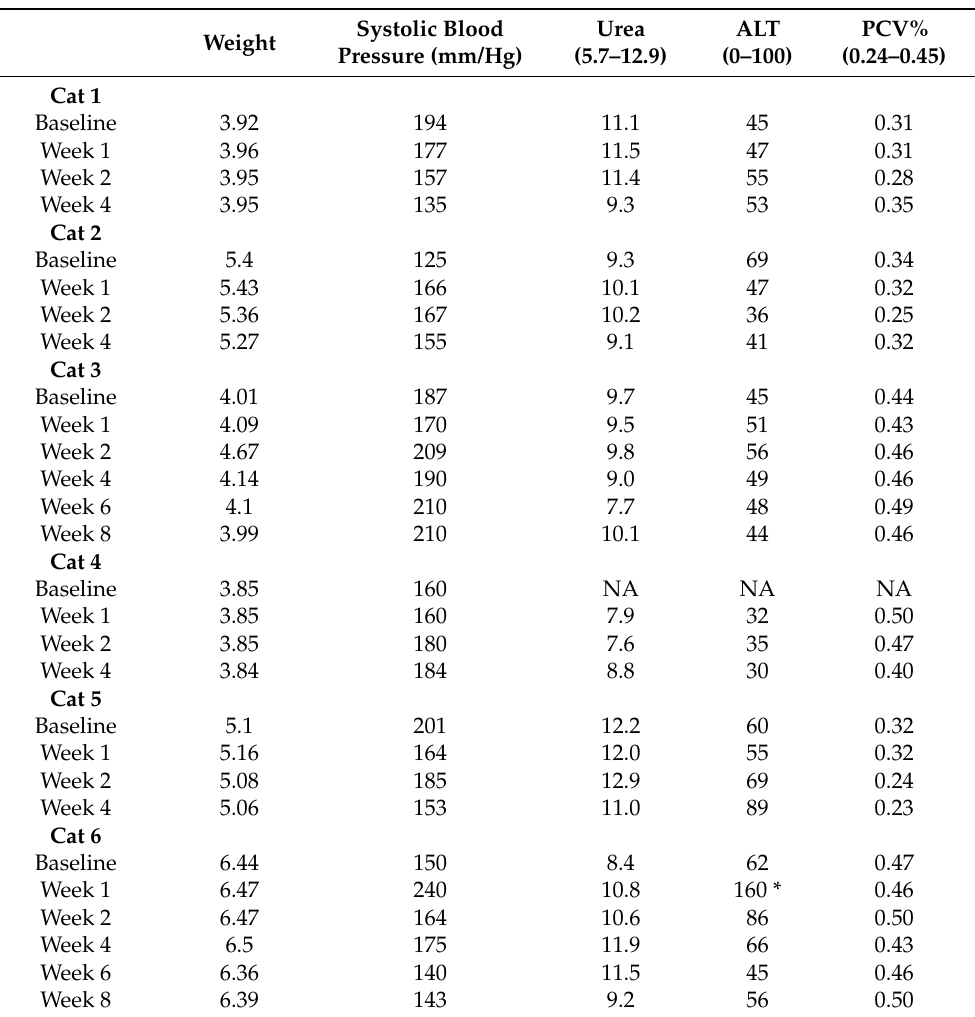
Table 4. Weight, systolic blood pressure, and select results of blood testing of cats receiving a multimodal blockade of the renin-angiotensin system. ALT is alanine aminotransferase activity (IU/L), PCV is the packed cell volume (%), urea is serum urea concentration (mmol/L). Values in brackets are the reference ranges as supplied by the veterinary diagnostic laboratory. * The sample contained hemolysis and this value is probably artefactually